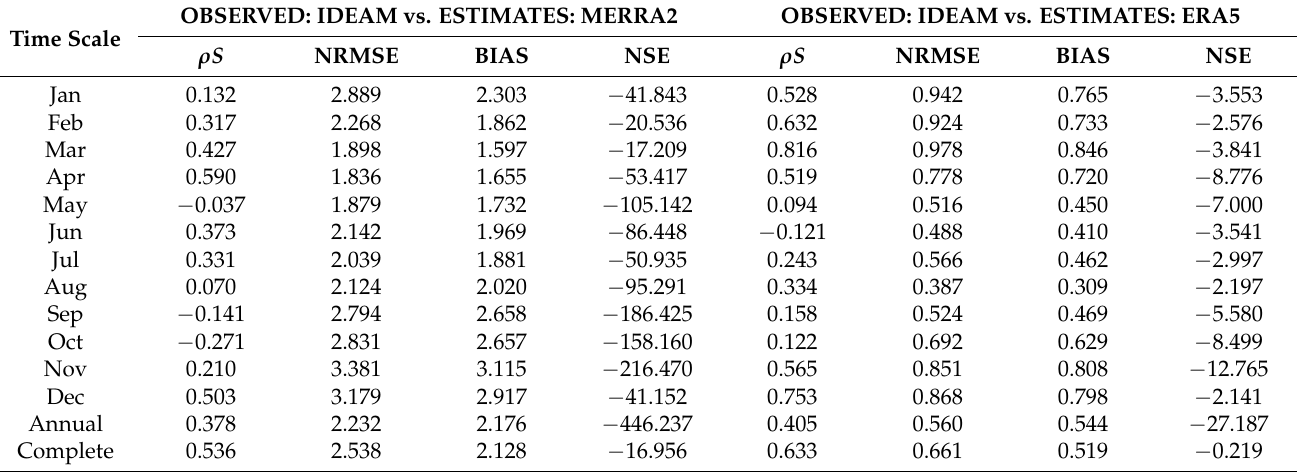
Table 1. Performance results for the tested reanalysis products for average areal rainfall estimations in the whole Sin ú River basin for 1985–2019.